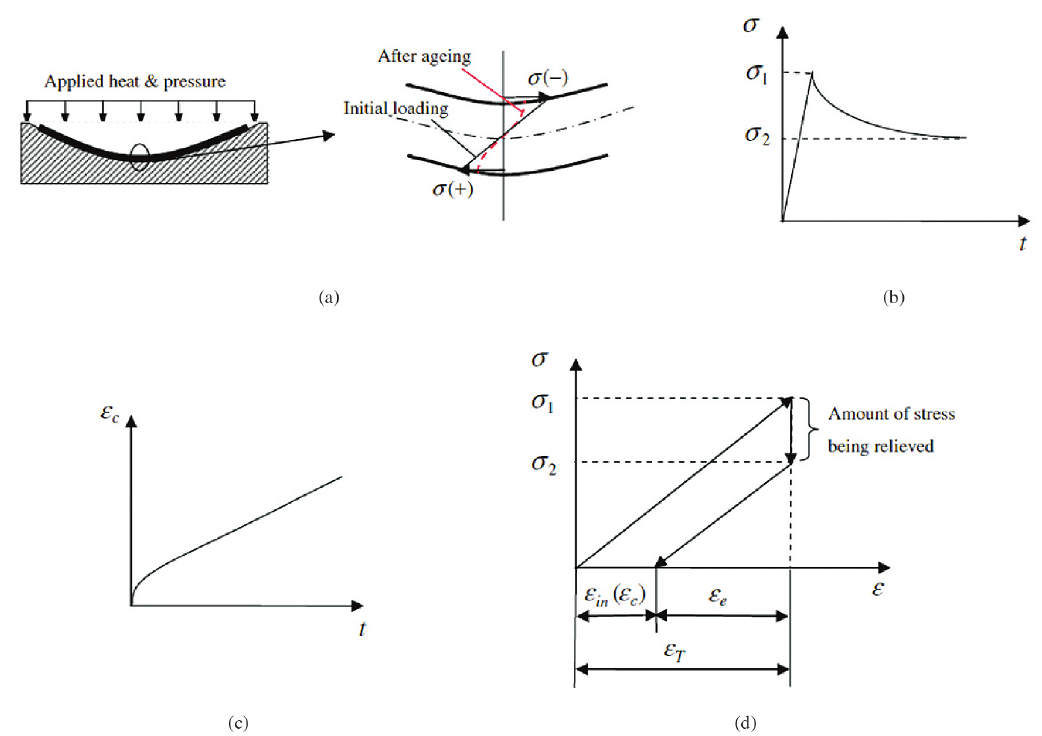
Figure 2. Forming mechanism of CAF under simple bending: (a) CAF under simple bending and stress distribution through thickness; (b) Stress relaxation - σ initial stress and σ threshold stress ; (c) Creep deformation; (d) Stress relaxation that occurs during CAF - σ 1 2 initial stress and σ threshold stress 5 2